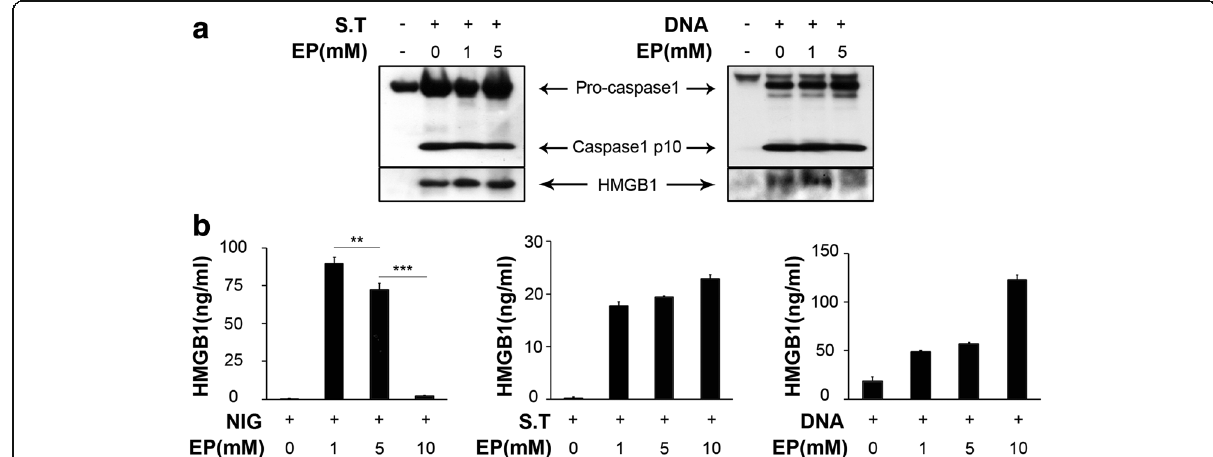
Fig. 2 Ethyl pyruvate specifically inhibits the NLRP3 inflammasome activation. For Salmonella infection, unprimed macrophages were infected with wild-type S. typhimurium and the supernatant samples were collected 1 h after infection. For the AIM2 inflammasome activation, macrophages were transfected with DNA using Lipofectamine 2000 and the supernatant samples were collected 6 h after transfection. a Pro-caspase1, caspase1 and HMGB1 release were assessed by Western-blot. b Supernatant levels of HMGB1were determined by ELISA. Results are means ± SEM (n = 3). * p < 0.05; ** p < 0.01; *** p <